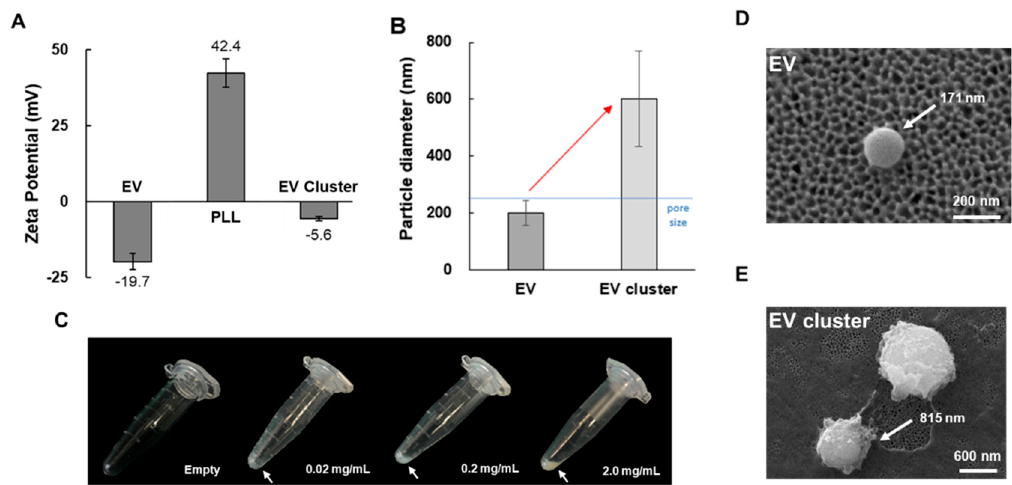
Figure 2. Cluster formation of EVs in plasma sample. ( A ) Zeta potential of EVs isolated by UC and PLL solution (10 mg / mL), and EV cluster obtained from UC sample. ( B ) Particle diameter of pure EV obtained by UC and EV cluster. ( C ) Images of precipitated pellet formation with varying PLL concentrations (0–2.0 mg / mL) with plasma sample. Incubation time was fixed at 1 h. ( D ) SEM images of EV isolated by UC and ( E ) EV clusters.